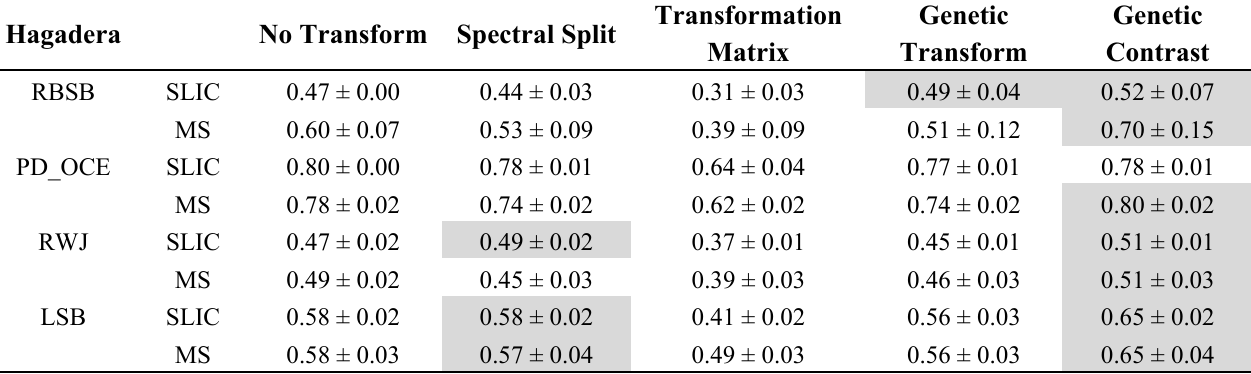
Table 3. Hagadera site